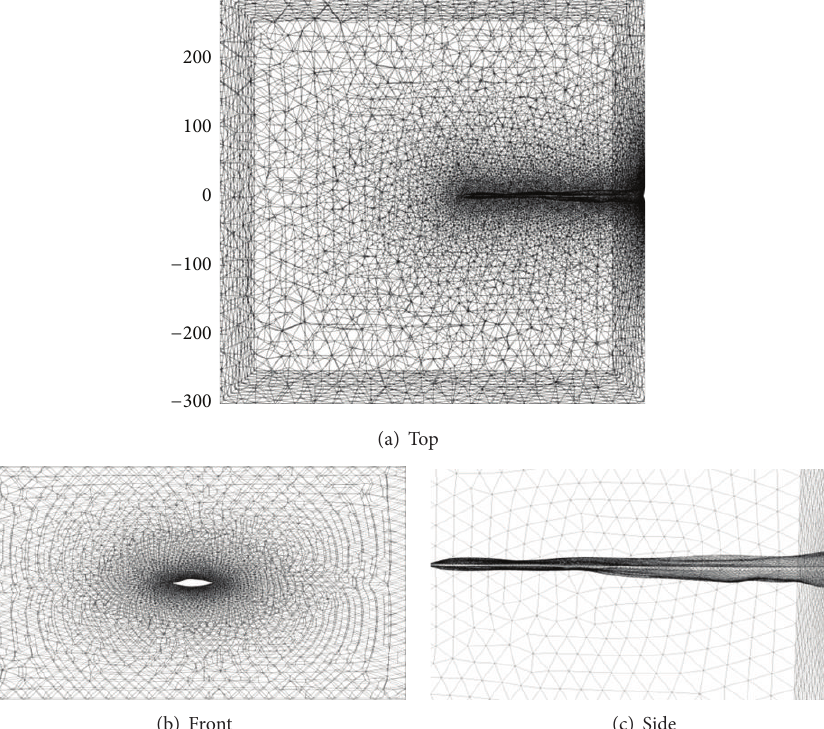
Figure 3: Paddlefish mesh showing domain extents and top front and side views.